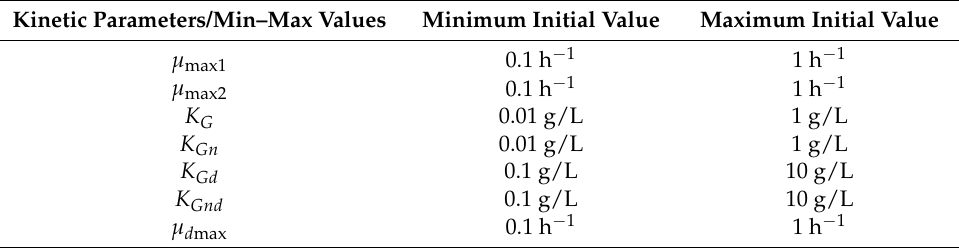
Table 1. Vertices of the multi-start parameter polytope.